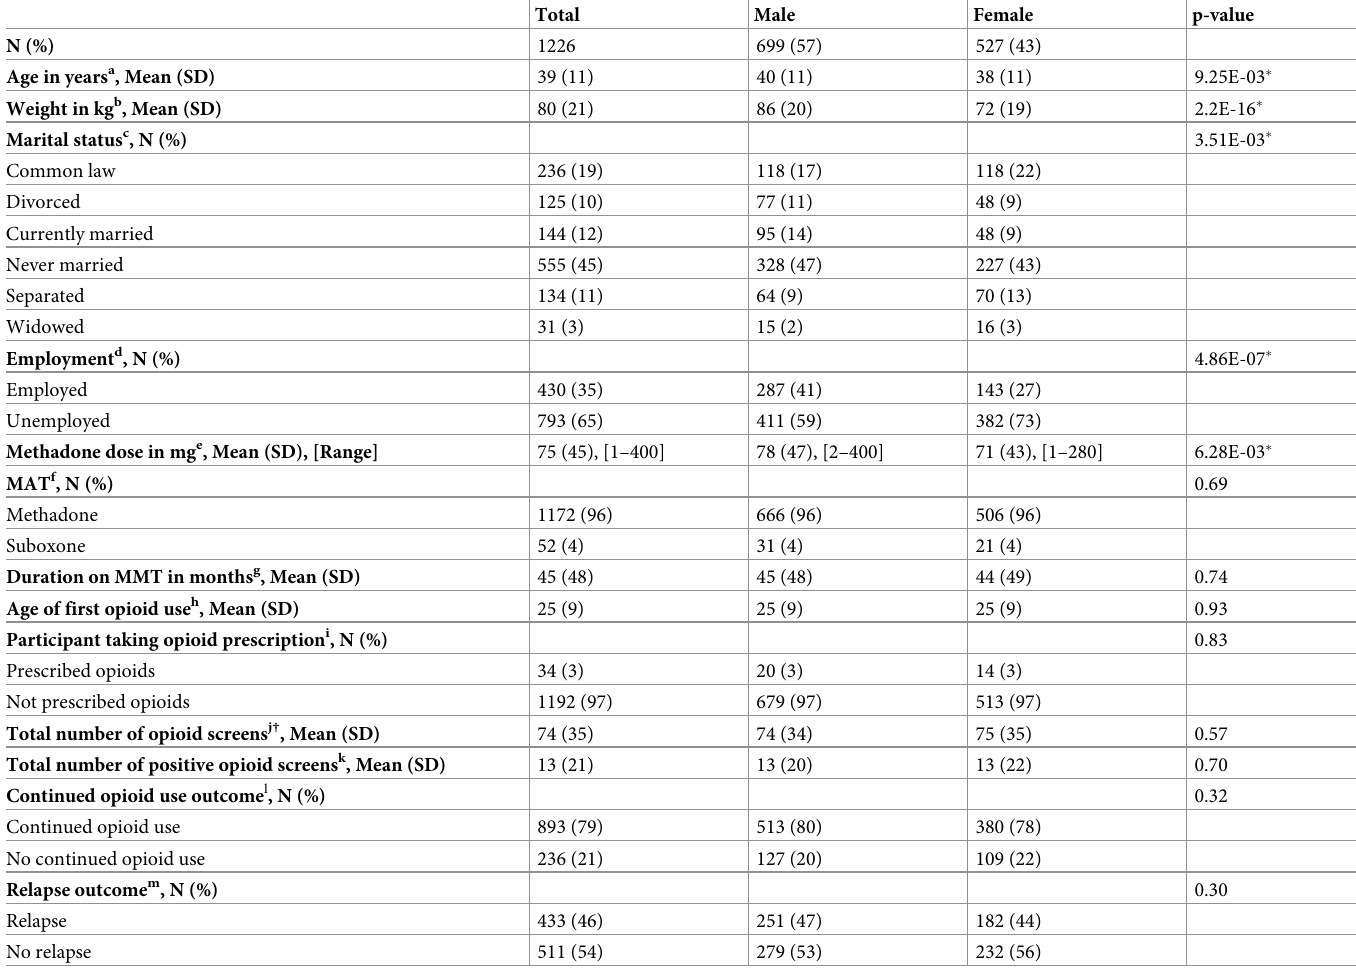
Table 2. Characteristics of participants of European ancestry with available genotype data in